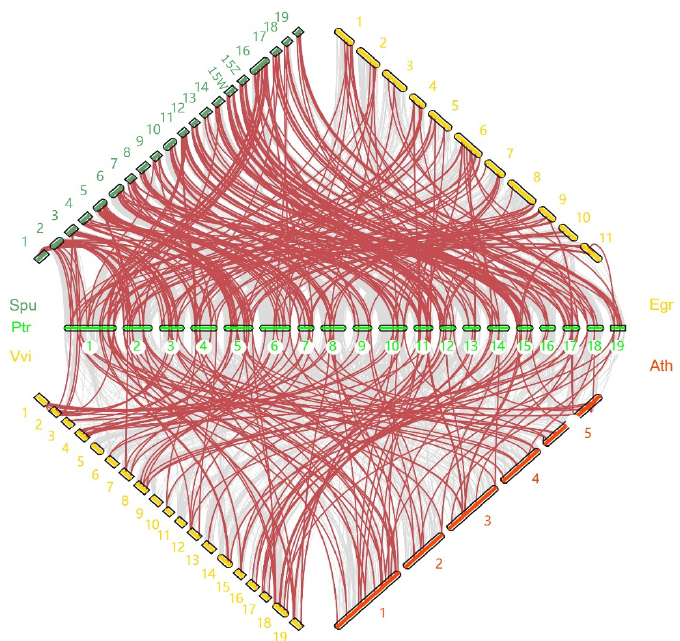
Figure 1. Distribution of NAC genes on the poplar genome. The blue lines inside the circle repre- sented PtrNAC duplicated gene pairs, rectangles indicated chromosomes of poplar, and the gray lines denoted all poplar duplicated gene pairs.